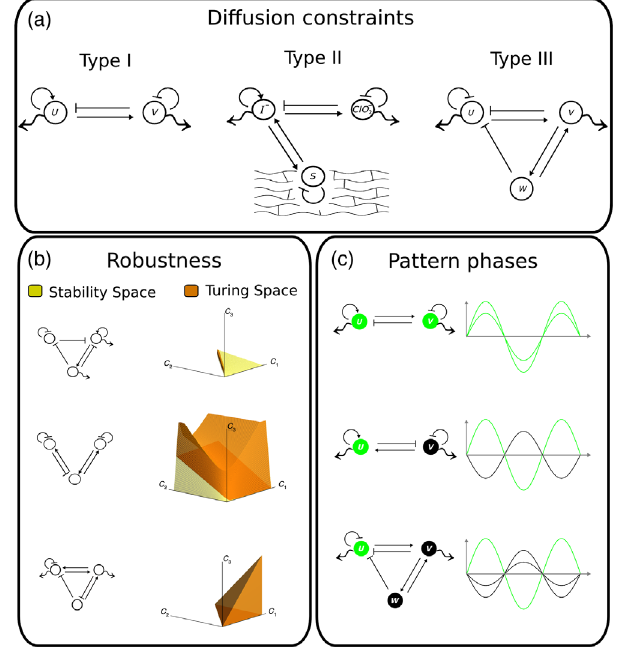
FIG. 1. Each panel illustrates a question about Turing systems that is resolved through analyzing the topology of the underlying network of interacting species. Namely, in a Turing system, how does the topology determine (a) the constraints on diffusion rates, (b) the size of the patterning parameter region, and (c) the phase of each species? More specifically, each panel contains three explicit networks with large differences in these properties. In all panels, edges ended with an arrow and a bar represent activation and inhibition, respectively. A wriggled arrow indicates that the node corresponds to a diffusible species. The two-species system illustrated in the left of (a) requires highly different diffusion rates of u and v for a pattern to exist, whereas the CIMA reaction schematic in the center can produce patterns with iodine ( I − ) and chlorite (ClO − 2 ) diffusing at the same rate. Finally, the network on the right produces patterns with no restriction on the diffusion rates. In (b), we see three three-species models whose Turing patterning parameter space are vastly different. The robustness of a patterning system can be assessed by the volume of the parameter sets compatible with reaction stability (shown in yellow) and diffusion-driven instabilities (shown in orange). For the three examples, the ratios of diffusion rates are the same, and the axes show the strength of the feedbacks between species. In (c), we present three networks and the prototypical patterns that they would produce in one dimension. The species whose concentrations are in phase are depicted in the same